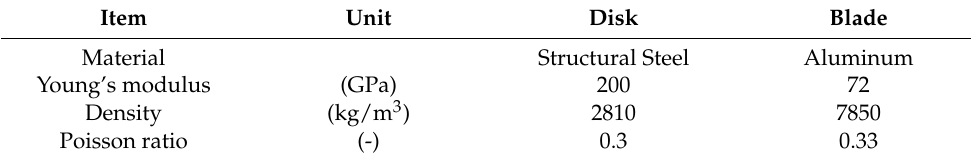
Table 3. Material